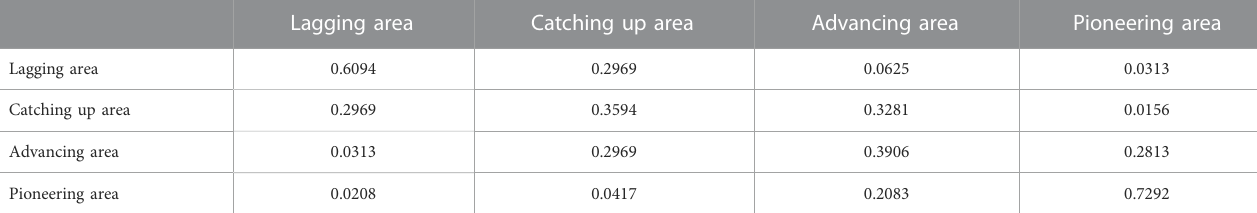
TABLE 2 Markov transition probability of the digital economy from 2011 to 2020.